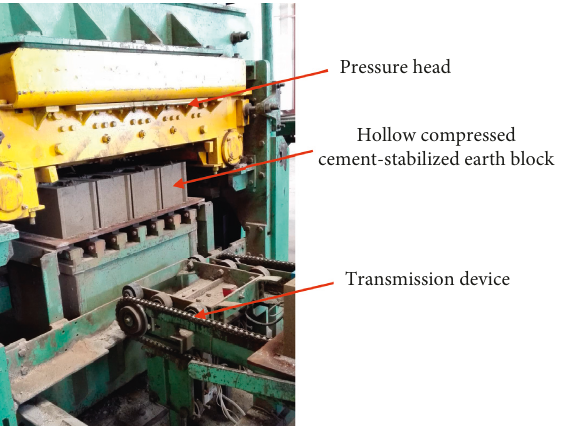
Figure 2: Machine used for manufacturing the